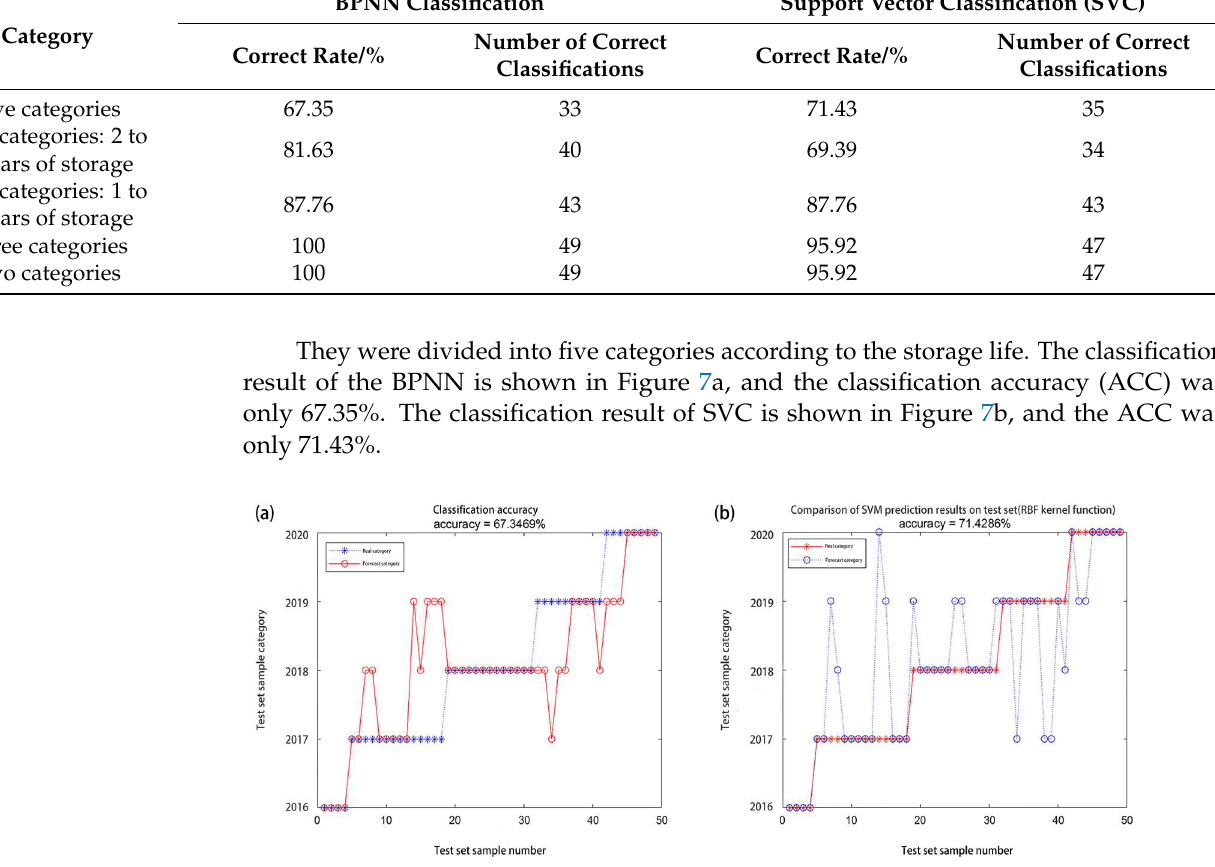
Figure 7. ( a , b ) represent the five categories results of catalase activity BPNN and SVC,